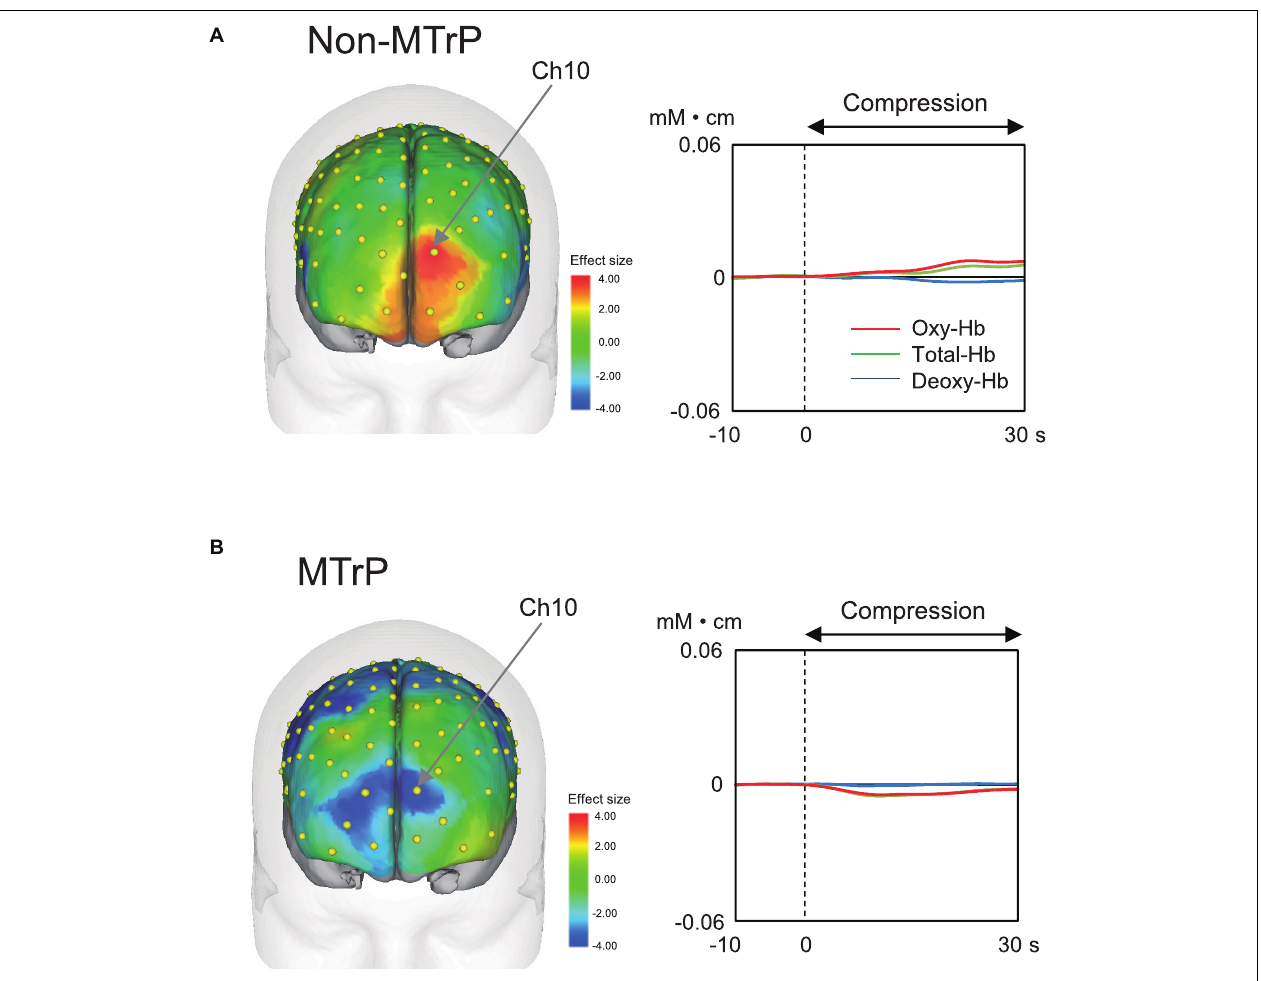
FIGURE 4 | Examples of hemodynamic responses during compression in the non-MTrP (A) and MTrP (B) groups. Topographical maps in the left indicate effect sizes of hemodynamic responses (change in Oxy-Hb concentration) during compression. Yellow dots indicate NIRS channels. The right graphs indicate temporal changes in hemodynamic activity during